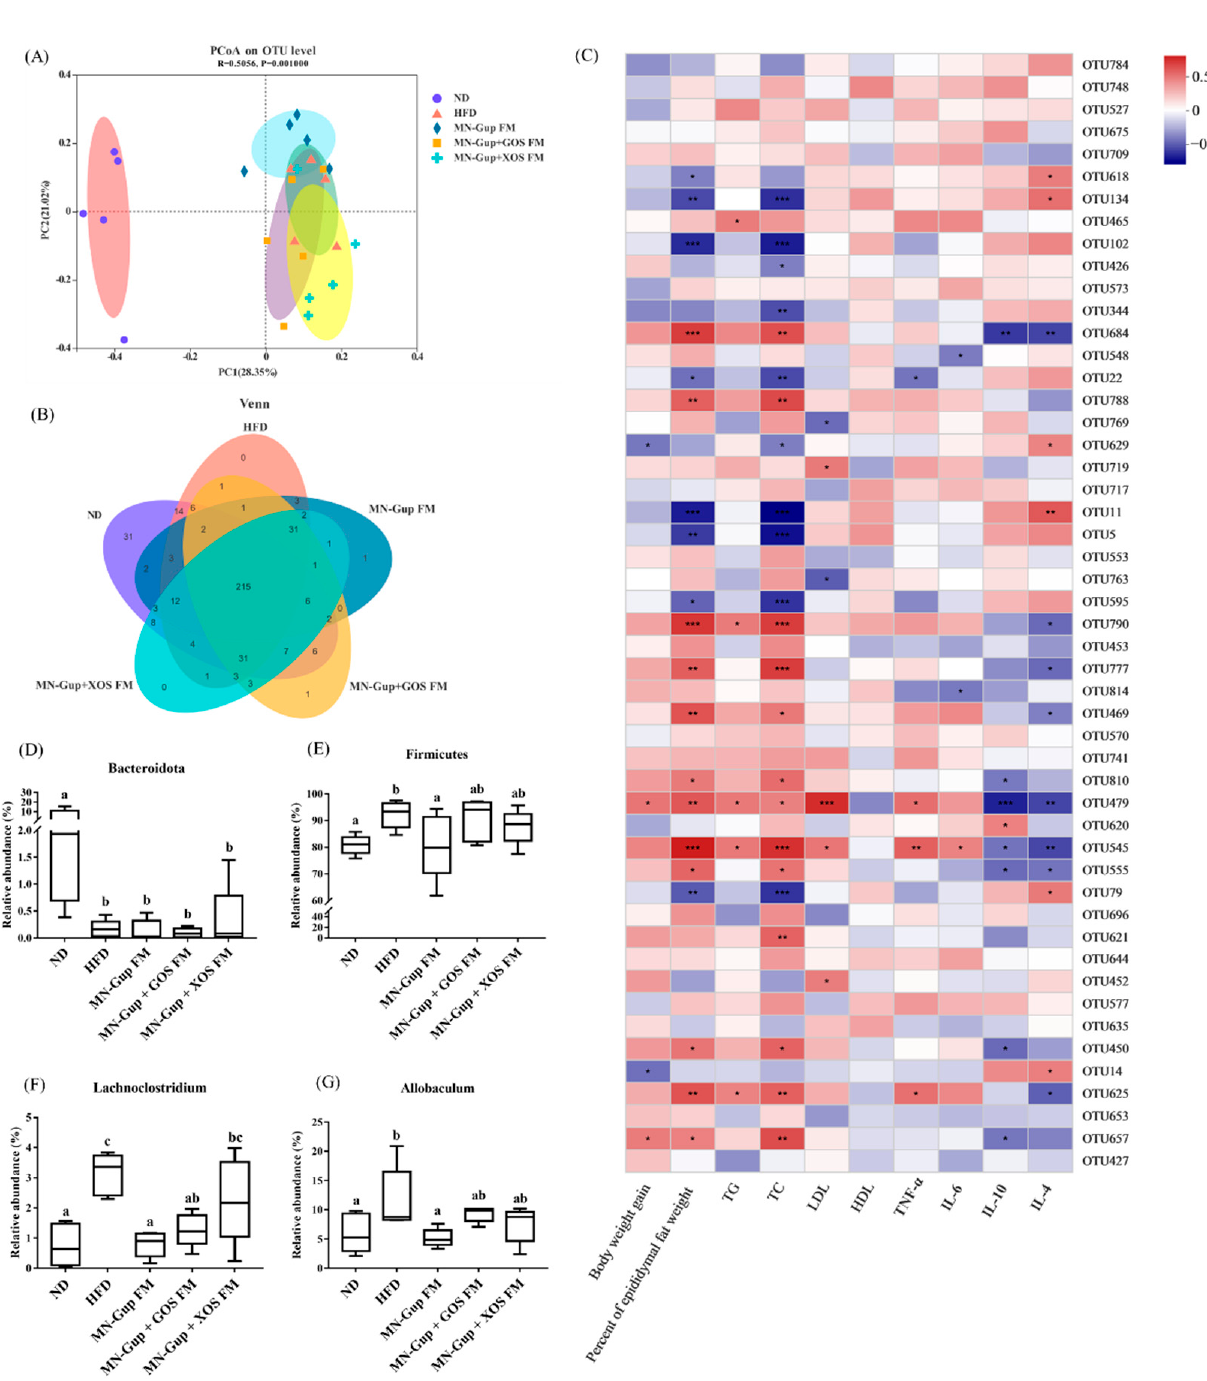
Figure 4. Effects of fermented milk containing MN-Gup or MN-Gup-based synbiotics on gut microbiota in HFD-induced obese rats. ( A ) Principal coordinate analysis (PCoA) based on bacterial operational taxonomic units (OTUs) using Bray-Curtis calculation; ( B ) Venn diagram; ( C ) the heatmap of correlation analysis between gut microbiota (based on OTUs) and obesity related indexes (significant correlations were noted by * p < 0.05, ** p < 0.01, and *** p < 0.001); ( D , E ) the significantly altered bacteria at phylum level; ( F , G ) the significantly altered bacteria at genus level (different lowercase letters (e.g., a, b, c) indicate significant differences, p < 0.05, n =